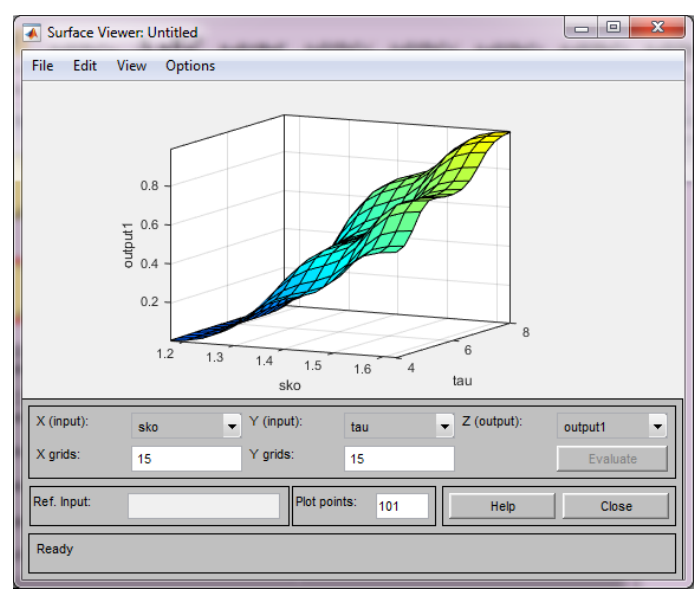
Figure 16. The plane of the domain of values at the output of the fuzzy logic algorithm.